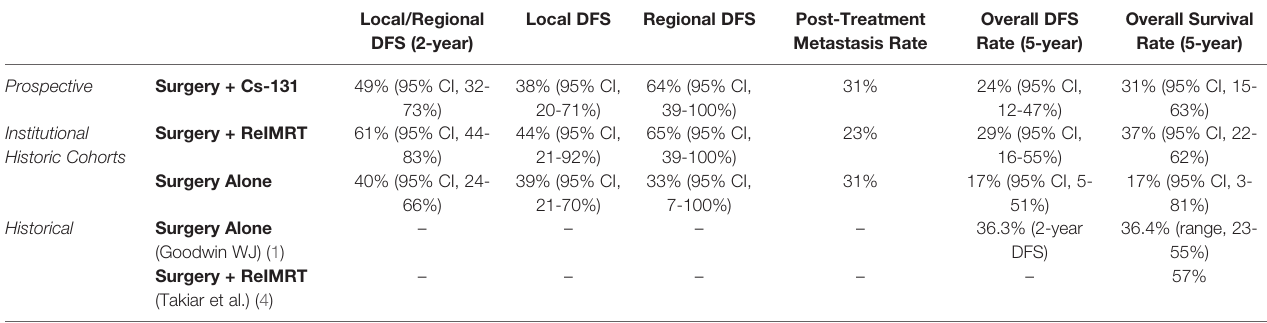
TABLE 4 | Oncologic